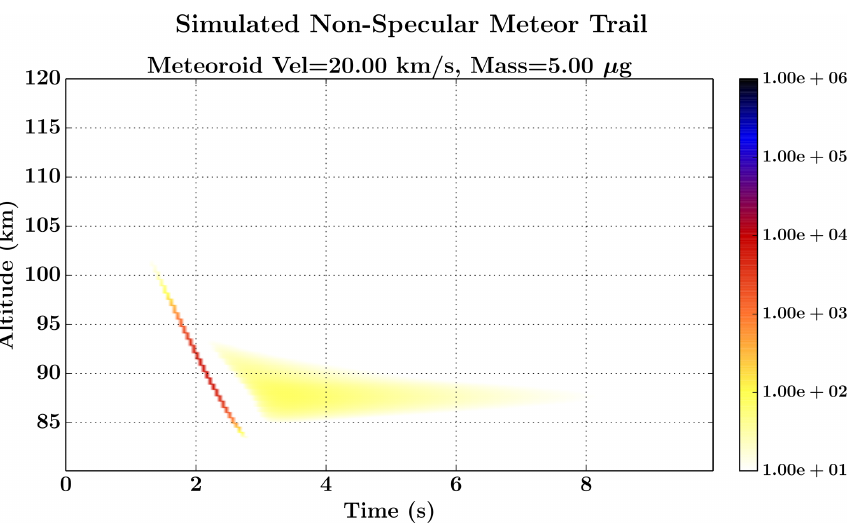
Figure 6. Meteor simulation to investigate the effect of weak neutral winds. In this example, instabilities take around 500ms to develop due to neutral winds of 2.2ms − 1